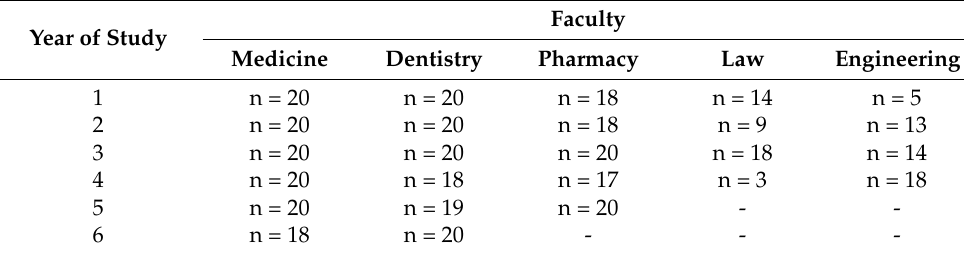
Table 1. Distribution of female students who had completed the survey by faculty and year of study. Year of